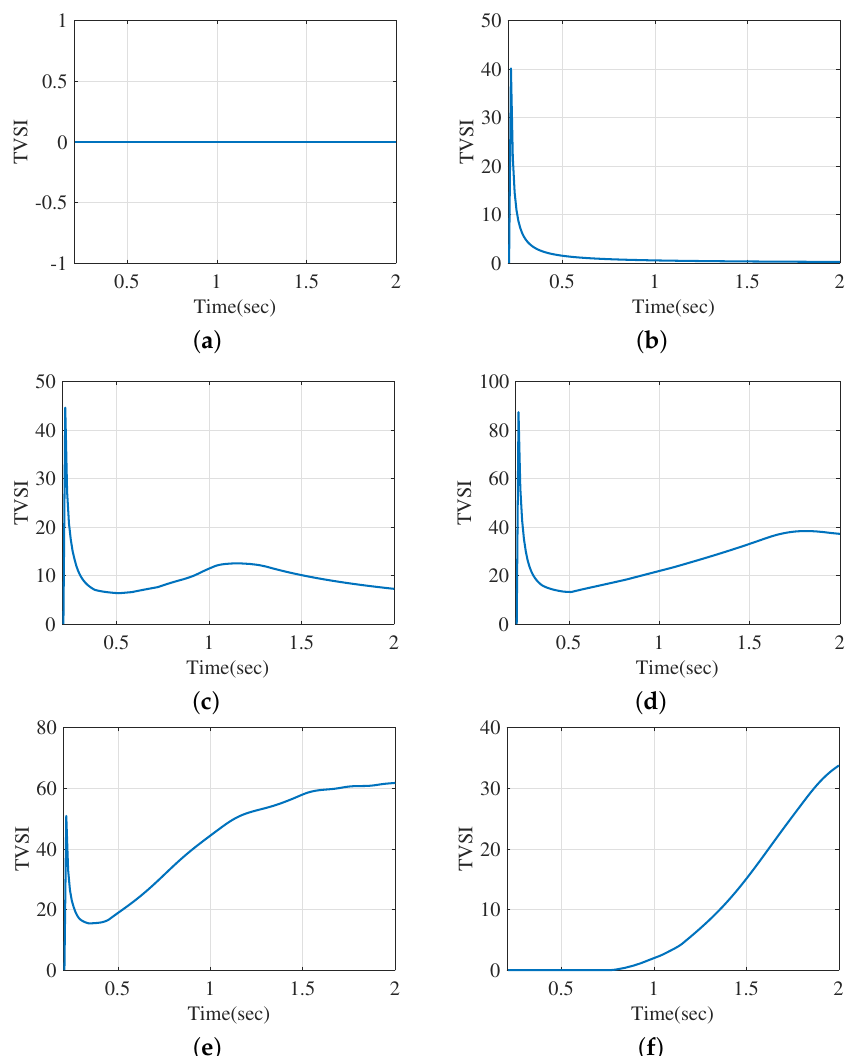
Figure 8. TVSI calculated for defined scenarios: ( a ) Case a, ( b ) Case b, ( c ) Case c, ( d ) Case d, ( e ) Case e, ( f ) Case